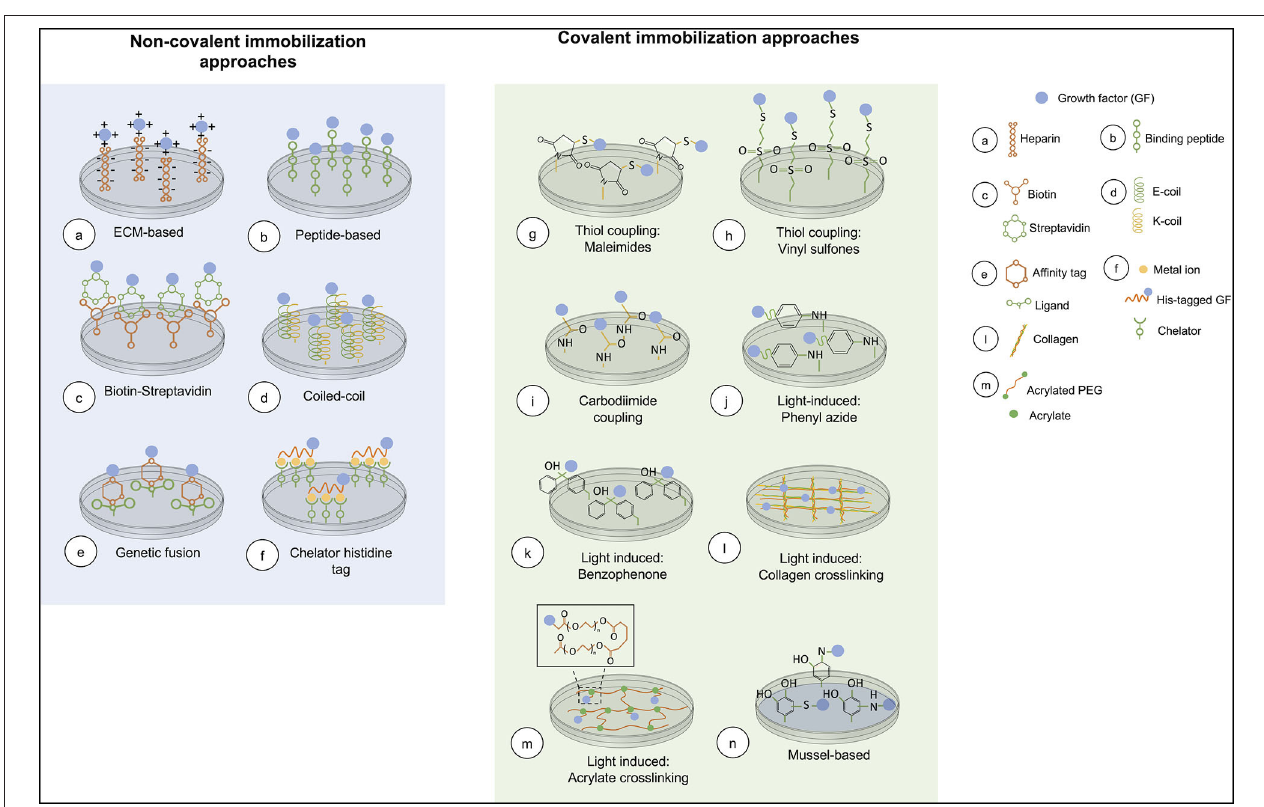
FIGURE 2 | Overview of current chemical immobilization strategies. In covalent methods, acrylate crosslinking is representative of the conjugation of an acryloyl GF and PEG-diacrylate matrix. While, mussel-based immobilization shows the interaction between the GF and polydopamine coated on the surface.